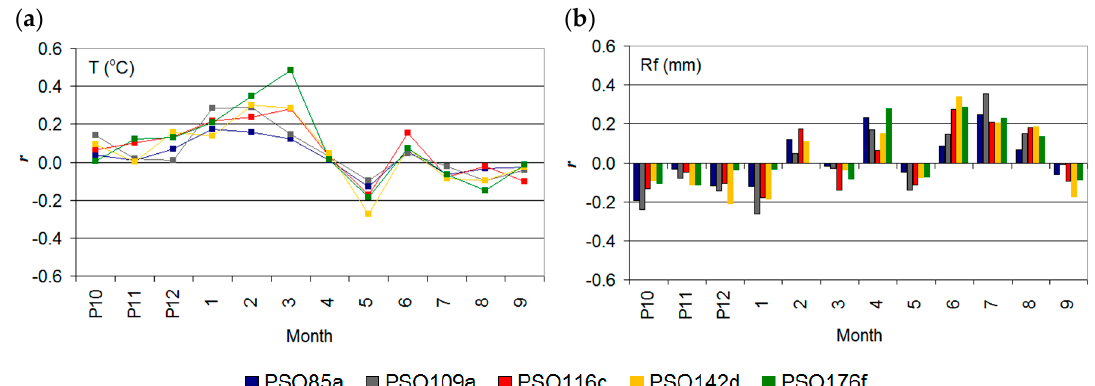
Figure 6. Pearson’s correlation coefficient for the relation of Scots pine site chronologies with meteorological elements—mean air temperature ( a ) and atmospheric precipitation total ( b ) 1930–2015; P—previous year.